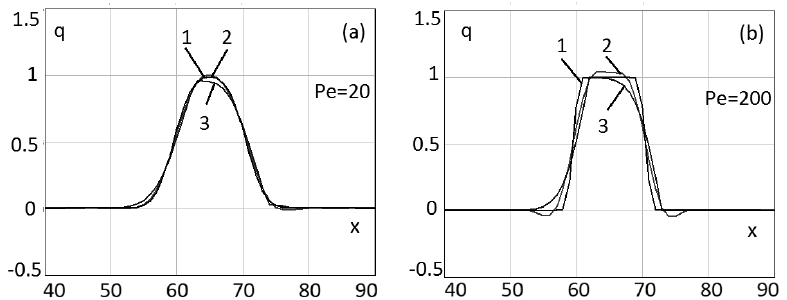
Figure 11. Solutions of the test problem IV for different values of grid Péclet number: ( a )— Pe = 20, ( b )— Pe = 200; 1—exact solution, 2—the difference scheme (47), 3—the Upwind Leapfrog difference scheme with